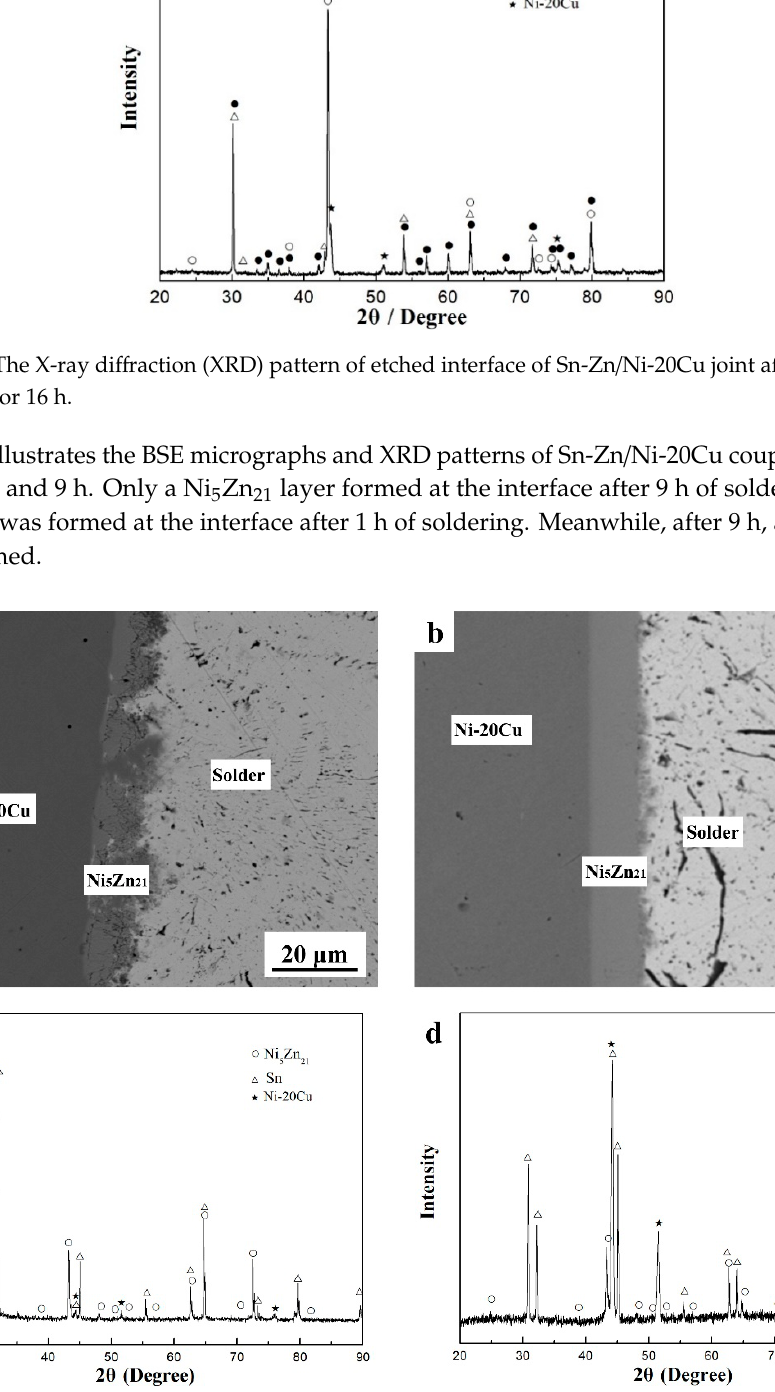
Figure 4. Cross-section micrographs ( a,b ) and X-ray diffraction (XRD) patterns ( c,d ) of Sn-Zn/Ni-20Cu joints after soldered at 250 °C for 1 h ( a,c ) and 9 h ( b,d ).